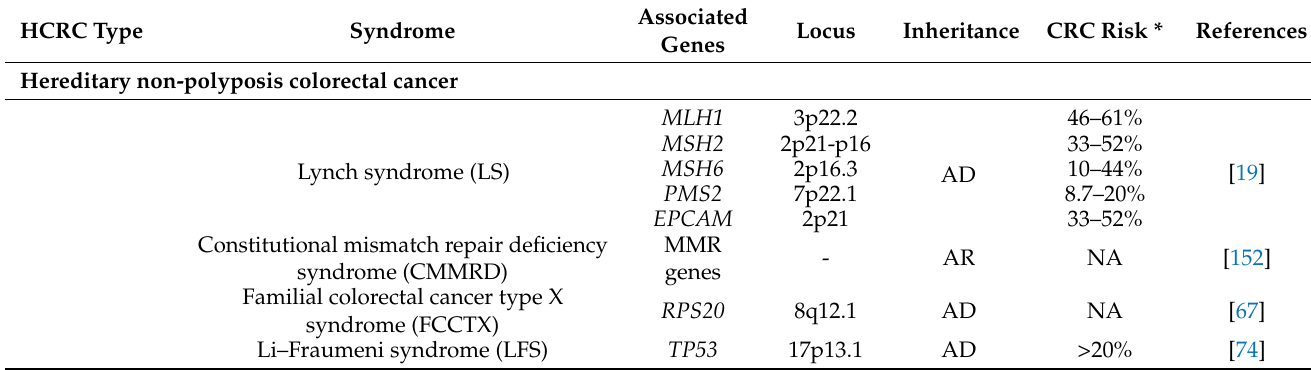
Table 1. List of the main syndromes associated with CRC with associated genes and CRC risk estimates. HCRC